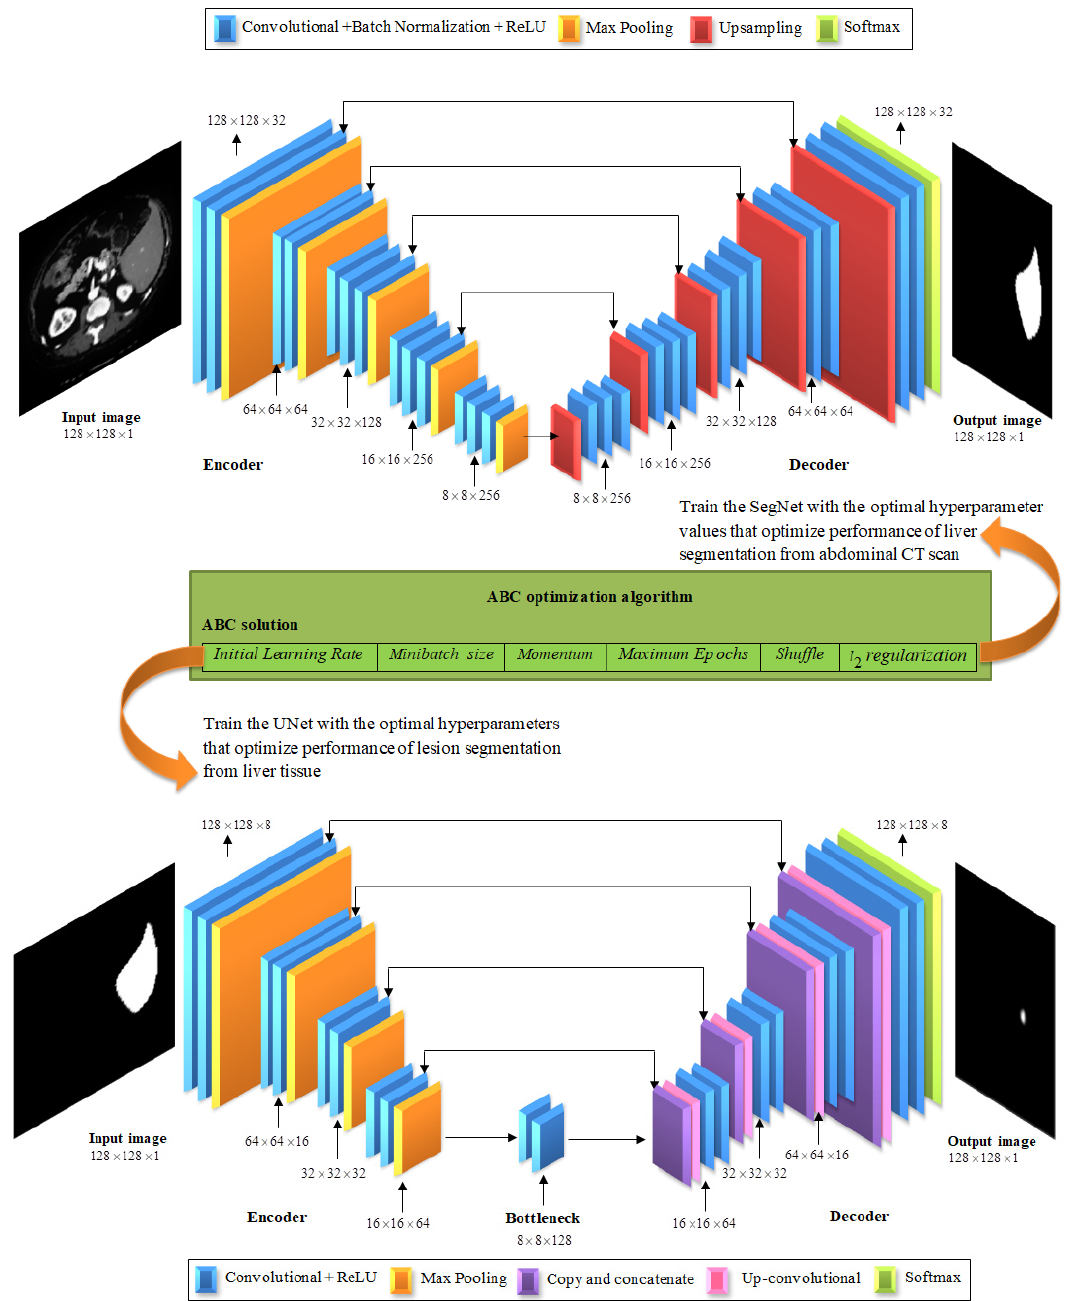
Figure 8. The proposed SegNet-UNet-ABC algorithm for segmenting liver lesions from CT images, which comprises three steps: (1) liver segmentation from the abdominal CT image using the SegNet network, (2) lesion segmentation from the liver tissue using the UNet network, and (3) optimization of segmentation performance of the SegNet and UNet architectures using the ABC algorithm.